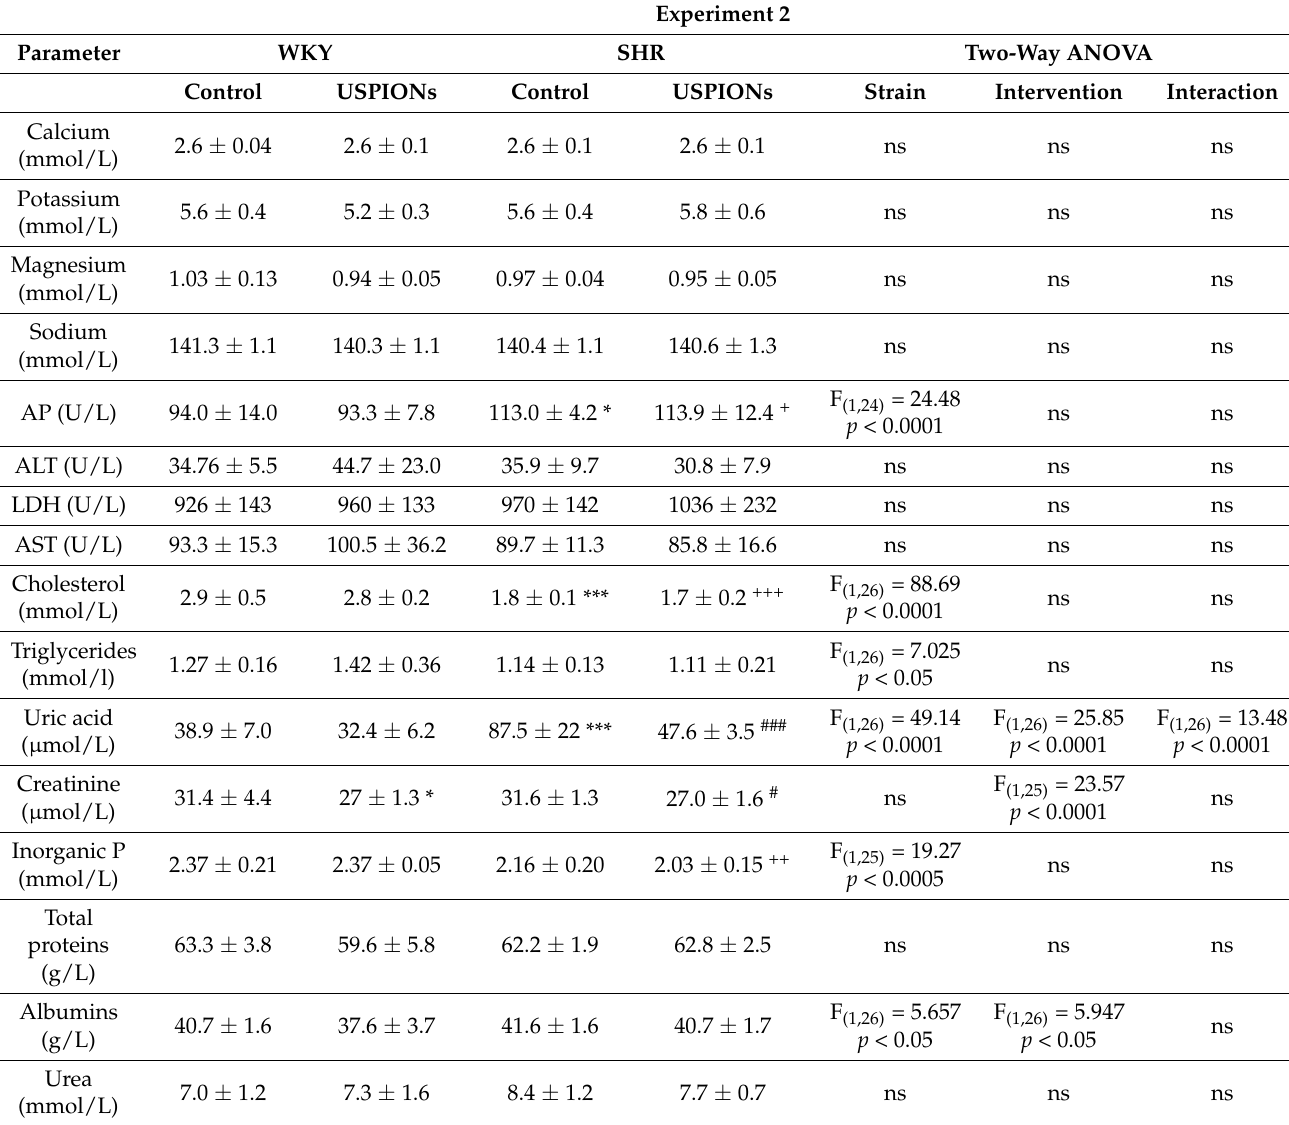
Table 2. Biochemical parameters determined in plasma after double administration of USPIONs at a dose of 2 mg of Fe/kg of body weight per day. Rats were killed approximately 24 h after the second USPION administration. Abbrevia- tions: USPIONs, ultra-small superparamagnetic iron-oxide nanoparticles; WKY, Wistar Kyoto rats; SHR, spontaneously hypertensive rats; AP, alkaline phosphatase; ALT, alanine aminotransferase; LDH, lactate dehydrogenase; AST, aspartate aminotransferase; P, phosphate. Results are presented as mean ± SD. * p < 0.05, *** p < 0.0001 vs. WKY control; + p < 0.01, ++ p < 0.005; +++ p < 0.001 vs. WKY USPIONs; # p < 0.01; ### p < 0.0001 vs. SHR